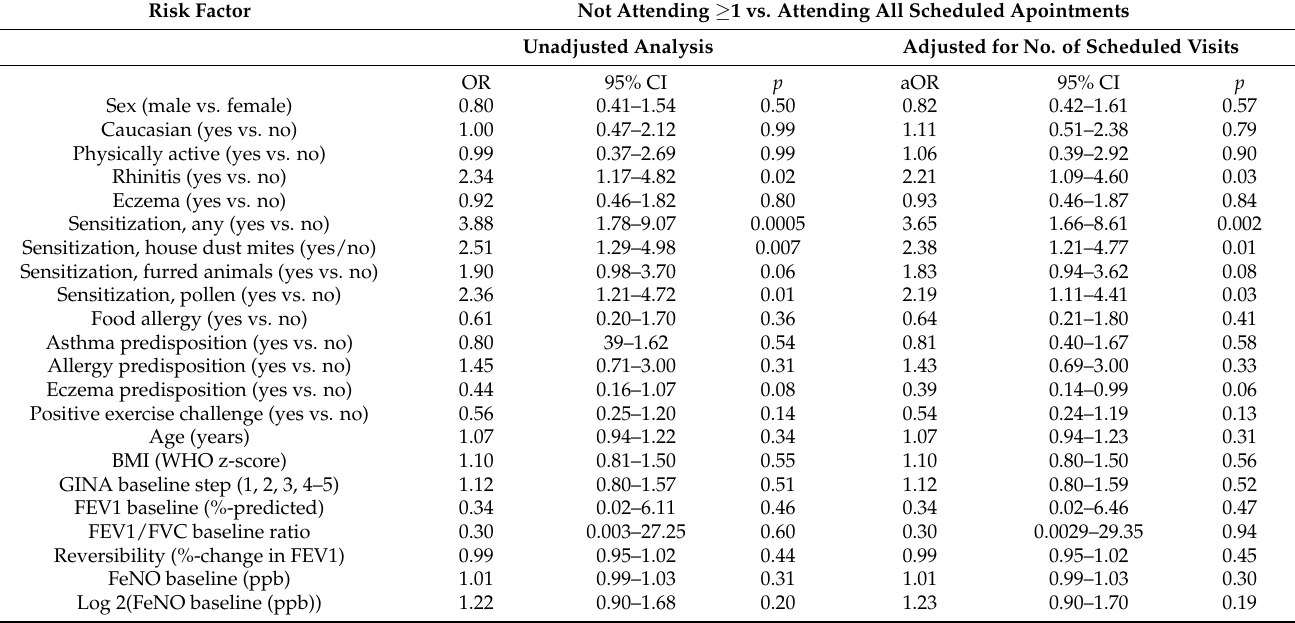
Table 2. Univariate risk factor analysis of not attending scheduled asthma outpatient appointments. Risk